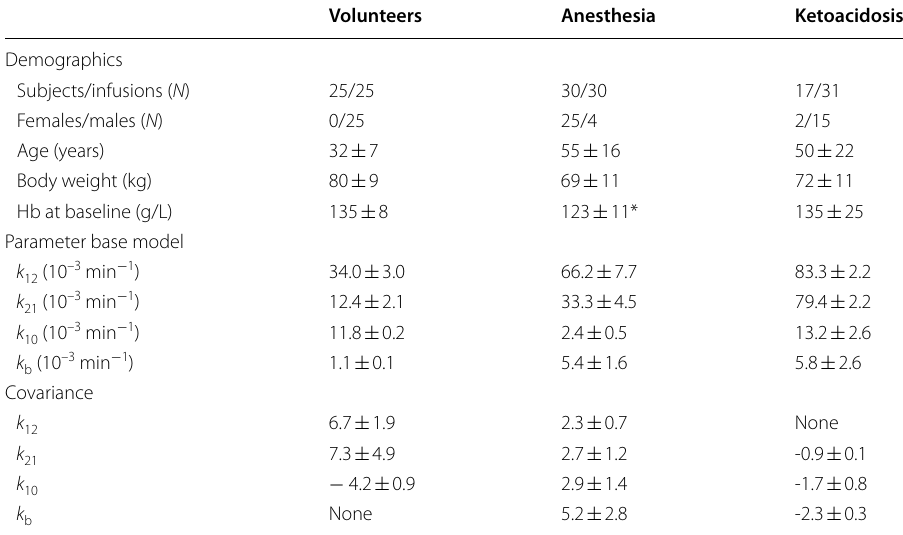
Table 1 Demographic data and volume kinetic analysis of the three series of crystalloid fluid infusions